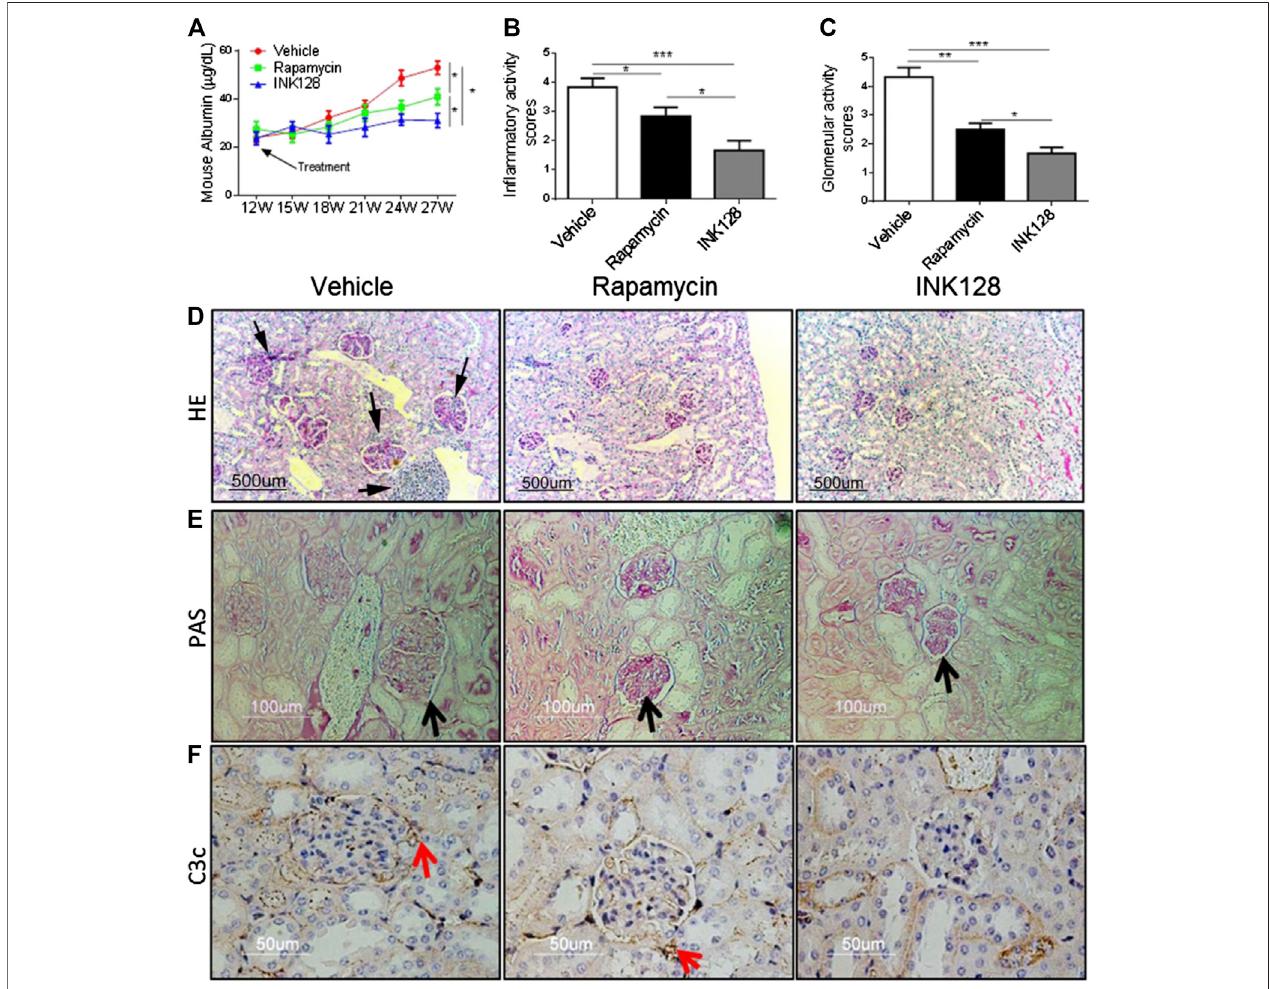
FIGURE 1 | INK128 attenuates symptoms of lupus-like disease in MRL/lpr mice. (A) Proteinuria was determined in each experiment using ELISA. Data are the median ± interquartile range from 5 or 6 independent experiments with one mice per group for rapamycin group or other group. Analyzed by the non-parametric Mann- WhitneyU-test. (B – E) Kidney sections from MRL/lpr mice showed histologic differences. Hematoxylin and eosin (H,E) staining revealed anunevenrenal cortical surface within fl ammatory in fi ltrates inthevehicle-treated MRL/lprmice.Periodicacid – Schiff (PAS)stainingcon fi rmedtheexpansionofglomeruliinvehicle-treated MRL/lpr mice,withenlargedglomeruli,distensionoftubularlumina,proteincasts,andeitherepithelialorendothelialdeposits. (F) C3cdepositwasanalyzedbyIHCstaining.Data are the median ± interquartile range from 5 or 6 independentexperiments with one mice per group for rapamycin group or other group. Analyzed by the non-parametric Mann-Whitney U-test. (* p ≤ 0.05, ** p ≤ 0.01, *** p ≤ 0.001). INK128 reduces concentrations of auto-antibodies and inhibits activation of B